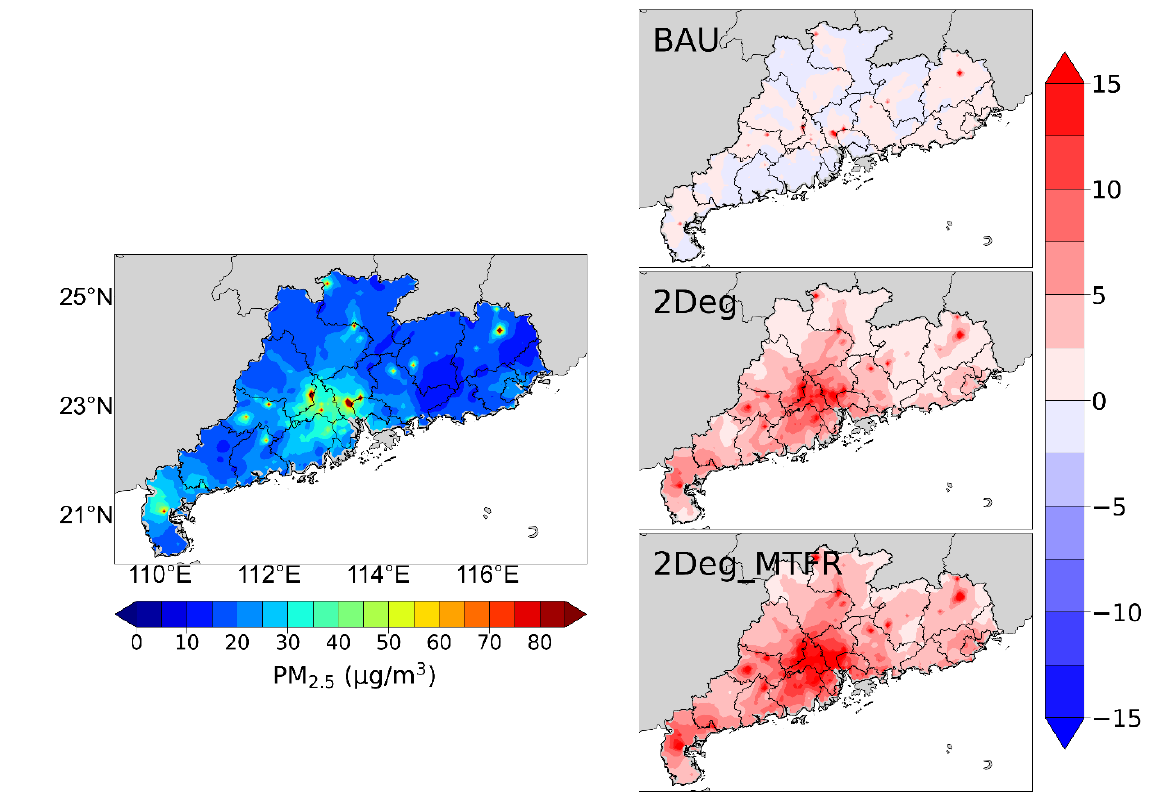
Figure 3. Spatial distribution of PM 2.5 concentrations in Guangdong in 2015 ( left figure ). The changing PM 2.5 concentrations under the three scenarios in 2050 ( right figures ), with red representing decreasing concentrations relative to 2015, and vice versa for